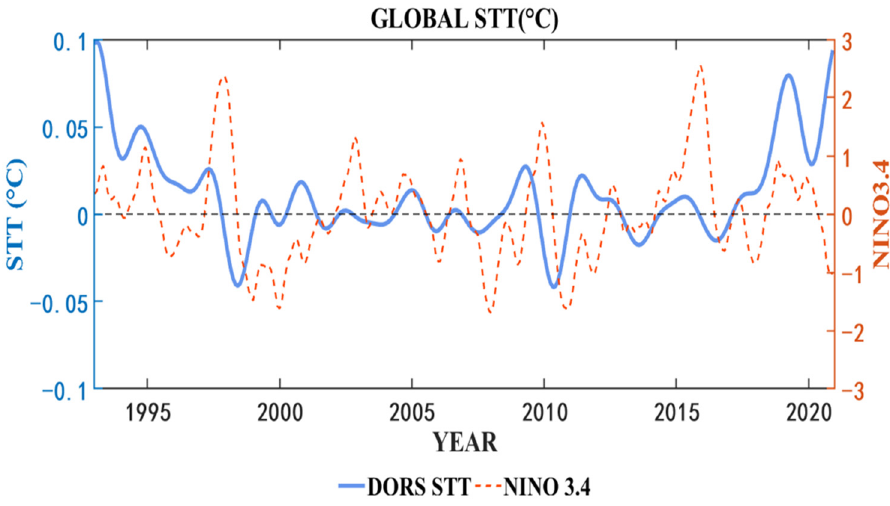
Figure 11. Time series evolutions of DORS STT and the NINO 3.4 index from 1993–2020.